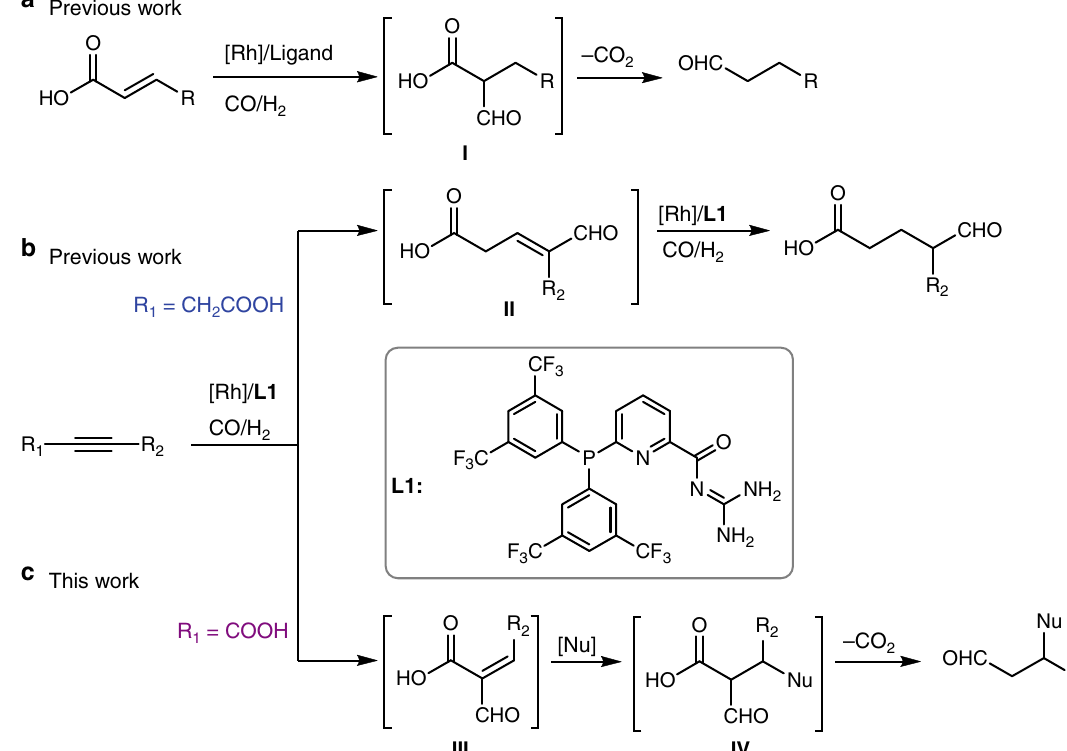
Fig. 1 Domino reactions supported by supramolecular Rh catalyst. a Rh-catalyzed hydroformylation of α , β -unsaturated carboxylic acids followed by decarboxylation sequence. b Rh-catalyzed hydroformylation – hydrogenation of β -alkynoic acids. c Rh-catalyzed hydroformylation of α -alkynoic